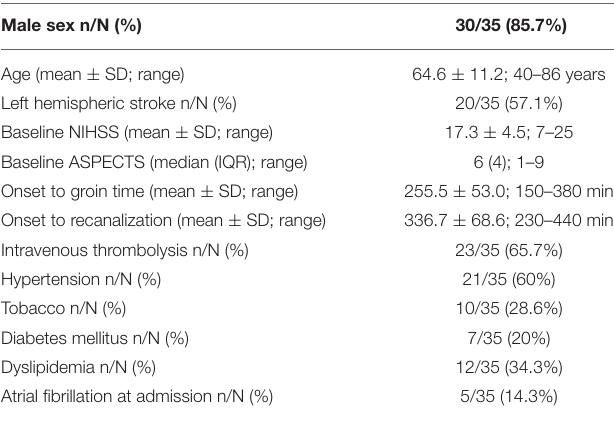
TABLE 1 | Demographic characteristics of the study